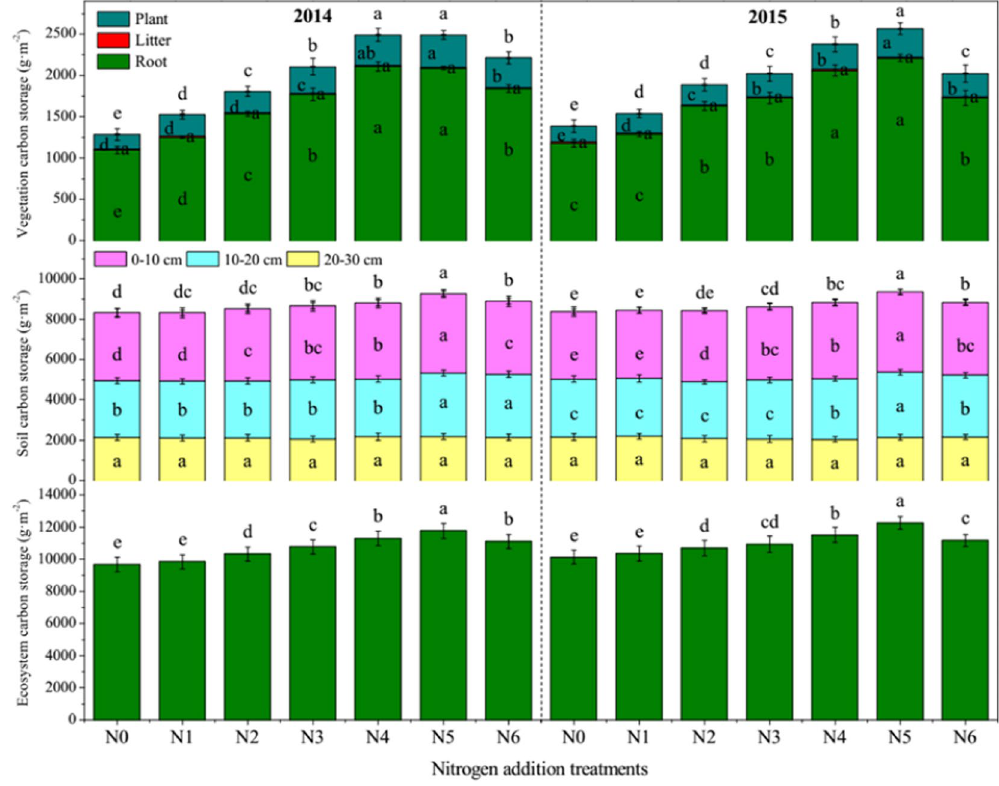
Figure 2. The organic carbon storage in vegetation, soil and ecosystem in an alpine meadow under different nitrogen addition treatments. N0, N1, N2, N3, N4, N5 and N6 represent 0, 54, 90, 126, 144, 180 and 216 kg N ha − 1 yr − 1 , respectively. Different letters indicate significant differences at P <